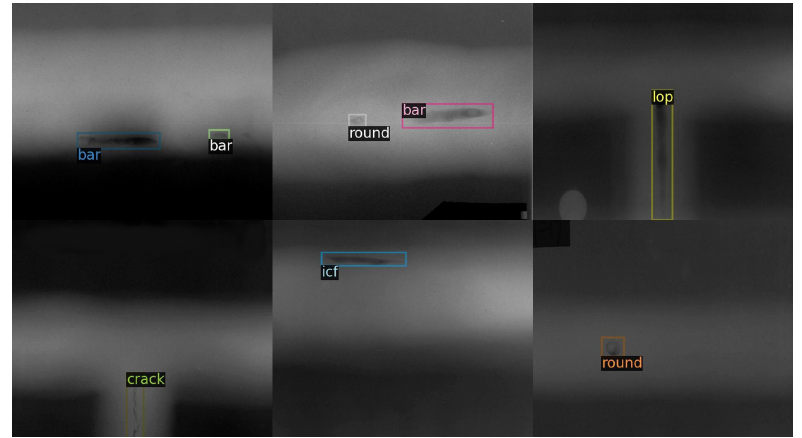
Figure 6. Weld defect dataset. Table 1. The number of each category in weld defect dataset.